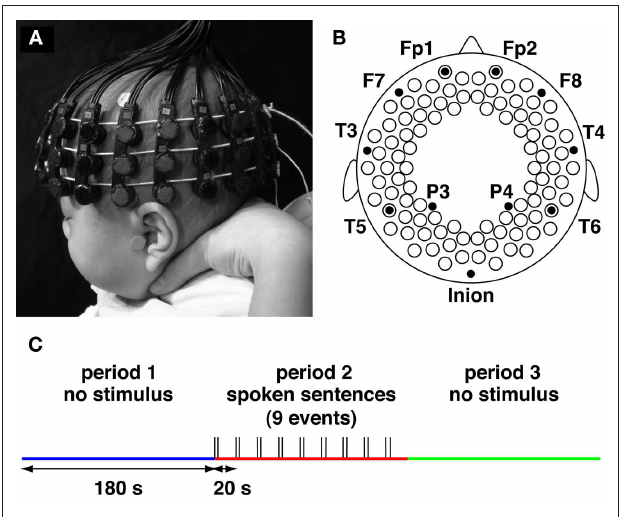
FIguRe 1 | experimental settings. (A,B) The NIRS probe and 94 measurement channels. Probes were placed over the bilateral frontal, temporal, temporoparietal, and occipital regions of infants. The probes and measurement channels (open circles in B ) were correctly positioned utilizing the 10–20 system. (C) Three periods during the measurement. During the first 3 min, we measured spontaneous brain activation (period 1). After period 1, we provided stimuli by playing Japanese sentences; the sentences were played at 20-s intervals for 3 min (period 2). Finally, we measured brain activation for 3 min without providing the stimulus (period 3), as in